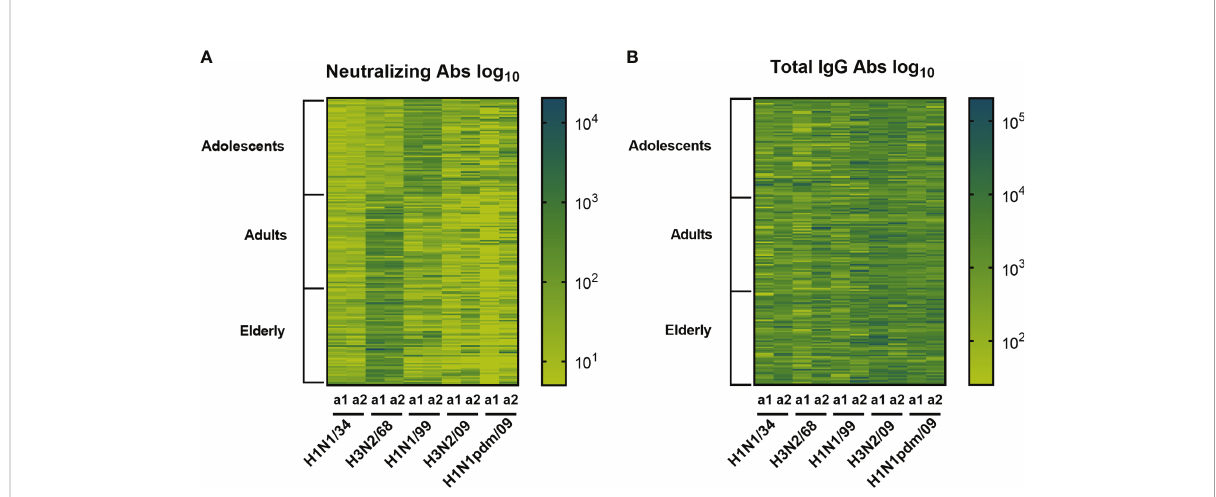
FIGURE 2 Heatmaps displaying in fl uenza speci fi c and neutralizing antibody titers and total IgG titers. Sera obtained from 180 subjects (belonging to three age cohorts: adolescents, adults, elderly) taken at 2 different time points (a1, a2) were assessed for virus neutralizing (A) and virus binding antibodies (B) against 5 historic in fl uenza virus strains indicated on the X axis. Each column represents responses (log 10 antibody titers) to one virus strain at one sampling moment (a1 or a2). Each row represents the responses of one individual. The darker the color the higher the antibody